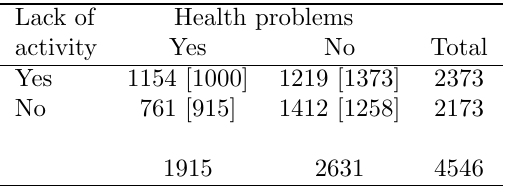
Rescaled contingency table for the relationship between physical activity and perceived health problems [corresponding theoretical independence frequencies] Lack